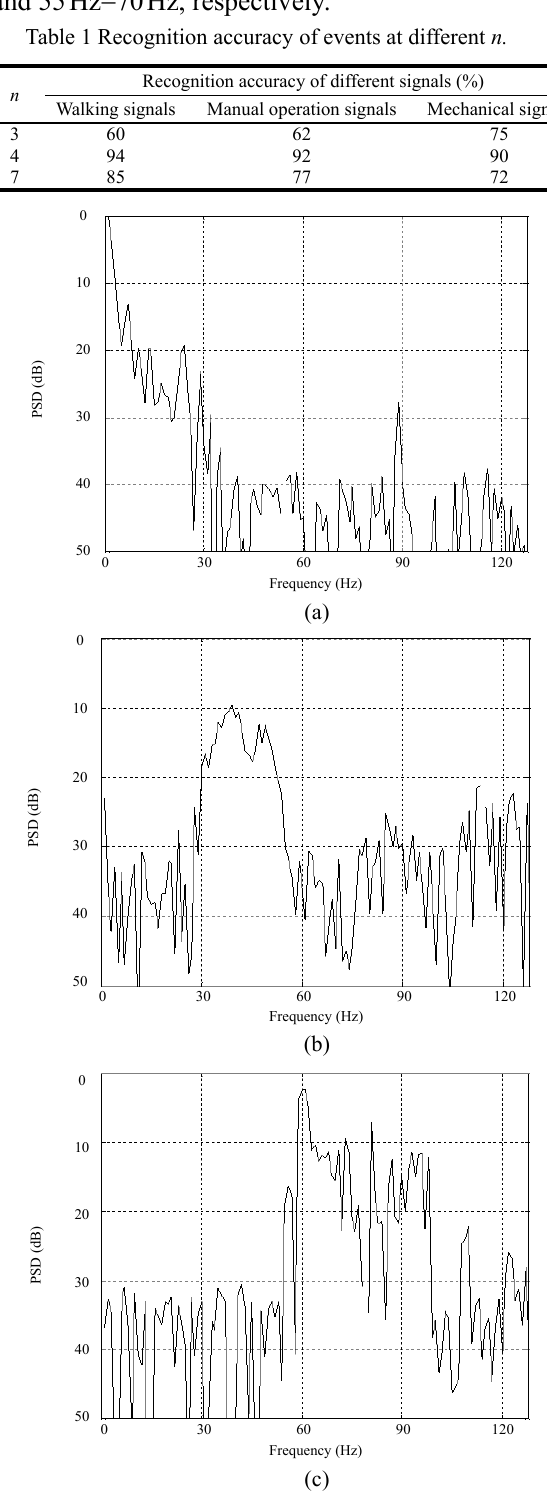
Fig. 7 Power spectral density of vibration signal: (a) walking signals, (b) manual operation signals, and (c) mechanical signals.